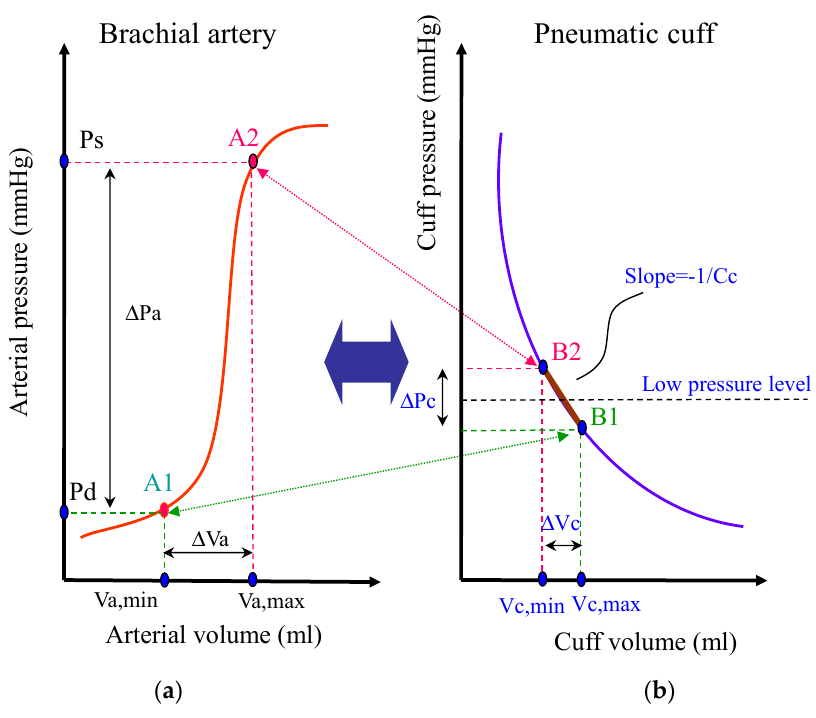
Figure 1. Schematic diagram of an air cuff bladder wrapped around an upper arm. V a and P a are the volume and pressure inside the brachial arterial segment L, and V c and P c are the volume and pres- sure of the cuff bladder, respectively.